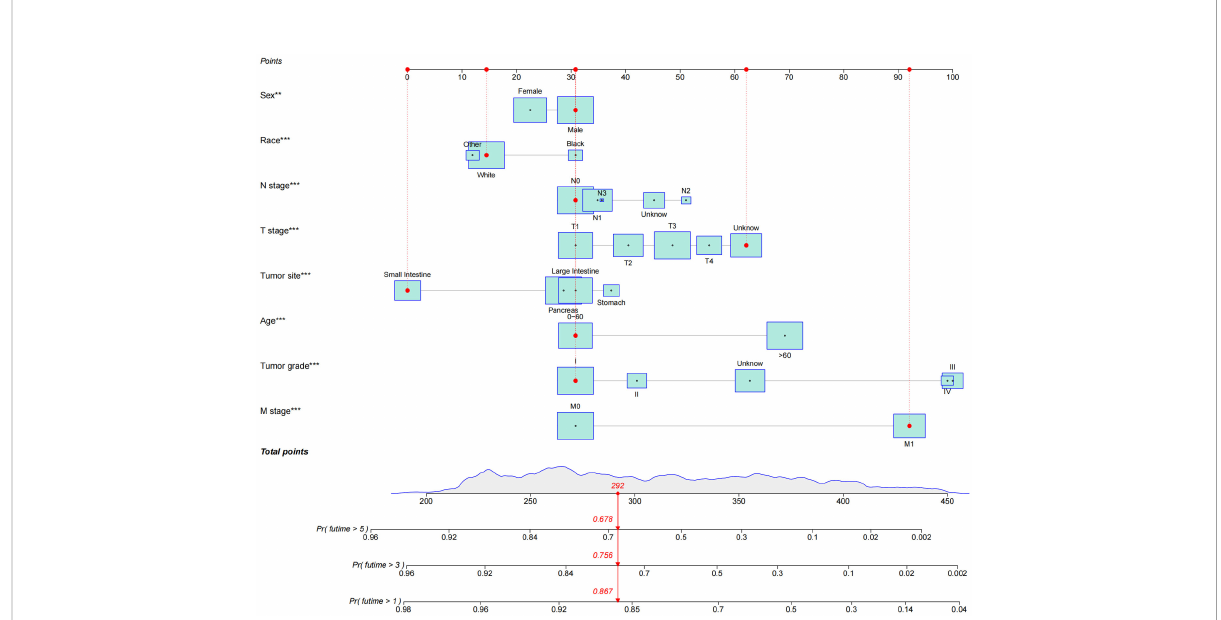
FIGURE 2 Nomogram of OS established to predict prognosis of patients with GEP-NECs. The red dots and red lines in the fi gure represent a random example. The patient was a white male younger than 60 years old with small intestine neuroendocrine carcinoma whose T stage was unknown, N stage was N0, M stage was M1, and tumor grade was G1. According to the rotors, the total score of the patients was 292; thus, the 1-, 3- and 5-year survival rates were 86.7%, 75.6%, and 67.8%, respectively.OS, overall survival; GEP-NECs, gastroenteropancreatic neuroendocrine carcinomas. ** P<0.01, ***